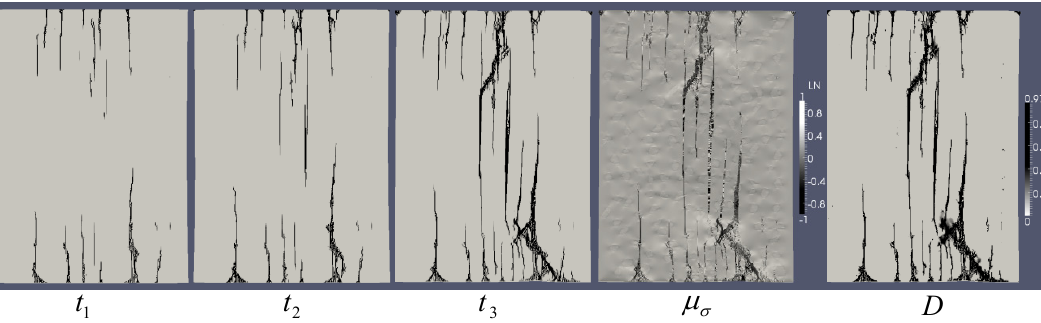
Figure 7: Simulation patterns: inelastic deformations (for three consecutive times), the stressed state ( composite specimen with 15% content of hardening particles in the case of friction on the loading